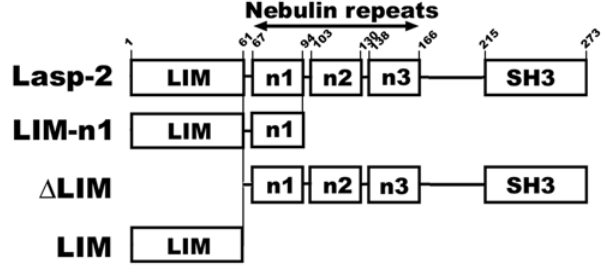
Figure 1. A schematic representation of the domain structure of avian lasp-2 and its fragments. LIM and SH3 indicate the LIM and Src homology 3 domains, respectively. The number of nebulin-repeats is shown by n1 to n3. The LIM-n1 fragment contains the LIM domain and first nebulin-repeat. D LIM is a deletion fragment of the LIM domain. The LIM fragment contains only the LIM domain. The numbers indicate the positions of the corresponding amino acid residues.